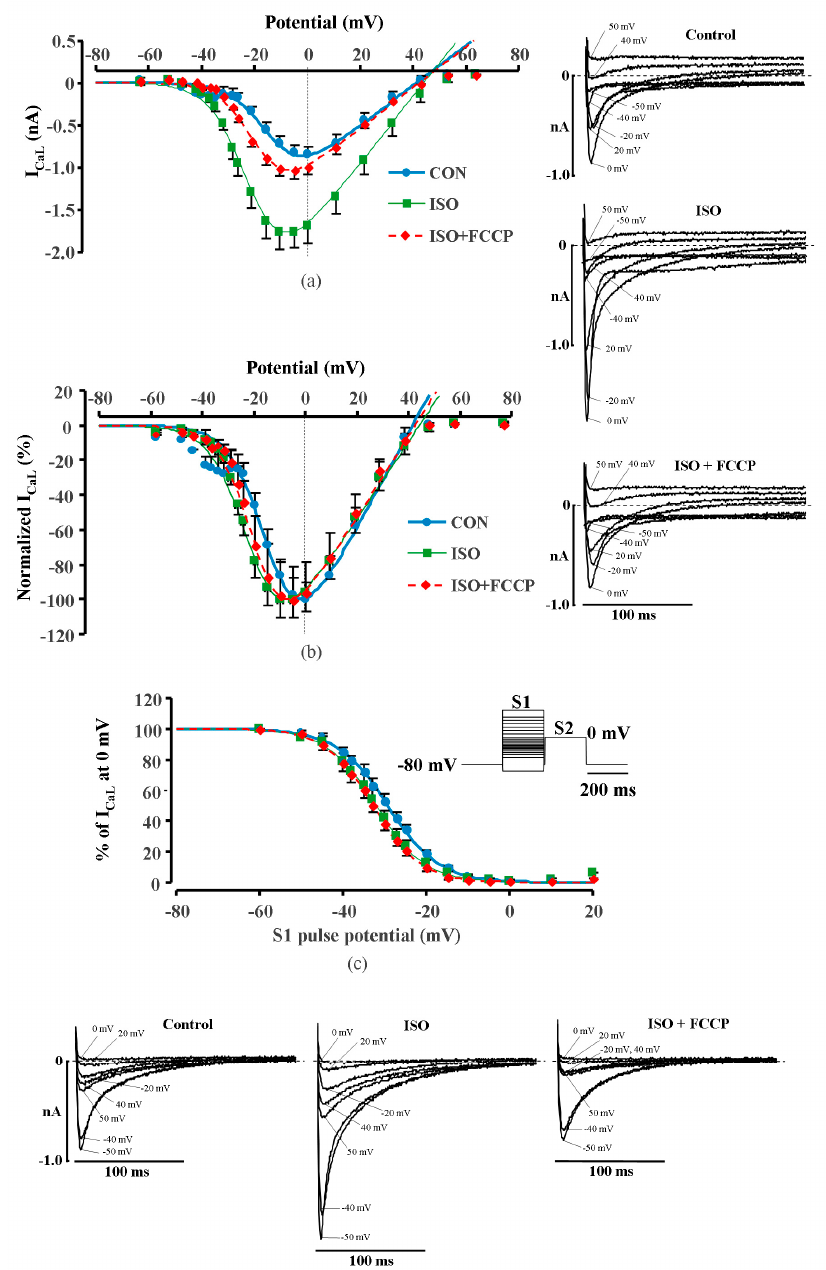
Figure 2. Current–voltage relationship and inactivation of I CaL in rat ventricular cells. ( a ) Current–voltage (I–V) relationship, ( b ) normalized I–V relationship. Insets on the right: I–V measurements (representative of traces of I CaL registered during S1 in control, in ISO stimulated cell and in the presence of FCCP). ( c ) Inactivation curves of I CaL under basal conditions, during ISO (1 µ mol/L) stimulation and during exposure to FCCP (100 nmol/L) in the presence of ISO in rat ventricular cells. Inset: Double-pulse protocol used for the inactivation curves (see Methods for details). I CaL peak amplitude during S2 pulse is expressed as a percentage of I CaL measured at 0 mV without conditioning pulse S1 and plotted as a function of S1 pulse potential. Points represent experimentally measured values; lines represent values calculated with Boltzmann equation. Insets below: Inactivation of I CaL (representative traces of I CaL registered during S2 in control, in ISO stimulated cell and in the presence of